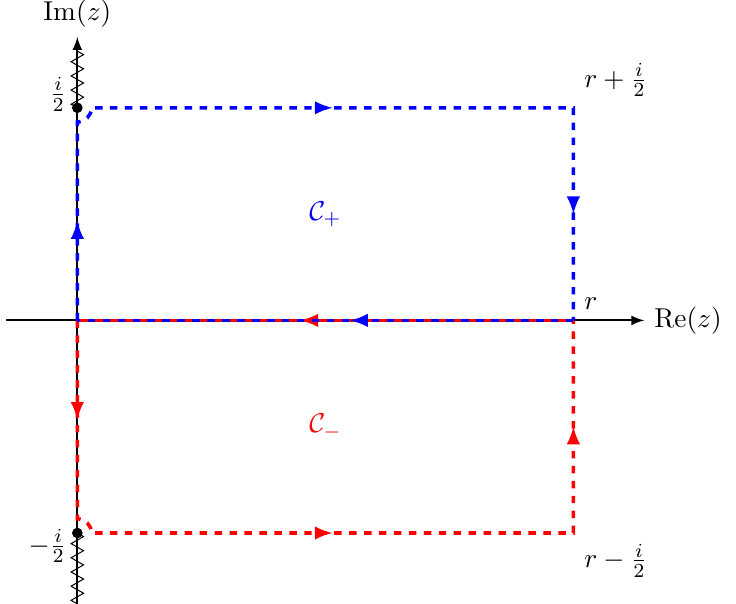
Figure 6 . The two contours in the complex plane. Contour C + goes clockwise passing through z = 0 , z = i , z = r + i , and z = r . Contour C − goes counterclockwise passing through z = 0 , 2 2 z = − i , z = r − i , and z = r . The two branch points at z = ± i/ 2 are depicted by the black dots. 2 2 Note that the contours do not cross the branch cuts, which is along the imaginary